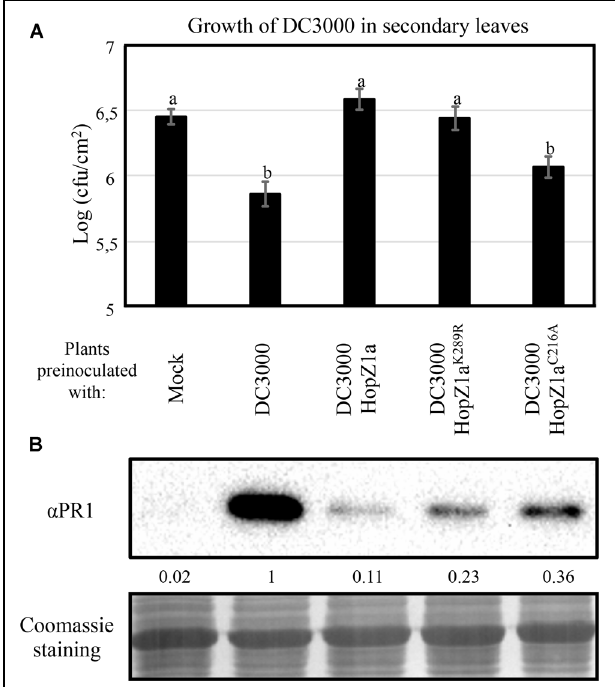
FIGURE 4 | HopZ1a-mediated suppression of SAR is reduced but not abolished by the K289R mutation. (A) Growth of DC3000 inoculated in secondary leaves of plants pre-inoculated in primary leaves by infiltrating either a 10 mM MgCl 2 solution (Mock), or 5 × 10 5 cfu/ml of DC3000, DC3000 expressing HopZ1a (pAME30), or DC3000 expressing the mutant derivatives HopZ1a C216A (pAME27) or HopZ1a K289R (pMAM1). Two days post-inoculation of primary leaves, secondary leaves were inoculated with 5 × 10 4 cfu/ml of DC3000, and growth was measured at 4 days post-inoculation of the secondary leaves. The experiment was repeated four times with similar results, and the results shown correspond to a representative experiment. The values shown represent the means of 5 biological replicates. Error bars represent the standard error. Values marked with the same letter were not significantly different from each other as established by Student’s t -test ( P < 0.05). (B) Western blot analysis for immunodetection of PR1 on distal non-inoculated leaves, 2 days after inoculating primary leaves with either 10 mM MgCl 2 (Mock), or 5 × 10 5 cfu/ml of DC3000, DC3000 expressing HopZ1a (pAME30), or DC3000 expressing the mutant derivatives HopZ1a C216A (pAME27) or HopZ1a K289R (pMAM1). Ten micrograms of total protein were loaded per sample, and Coomassie staining is shown as loading control. The signal intensity for each band was quantified using Fiji distribution of ImageJ software and is shown below the blot. The experiment was repeated twice with similar